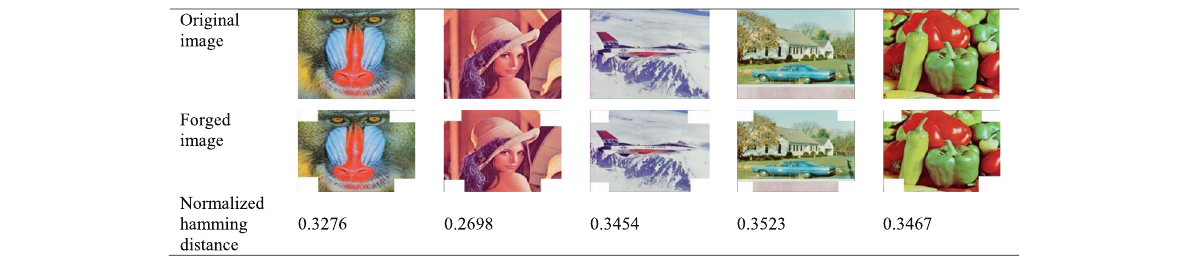
Table 7 Hash distances for forged images